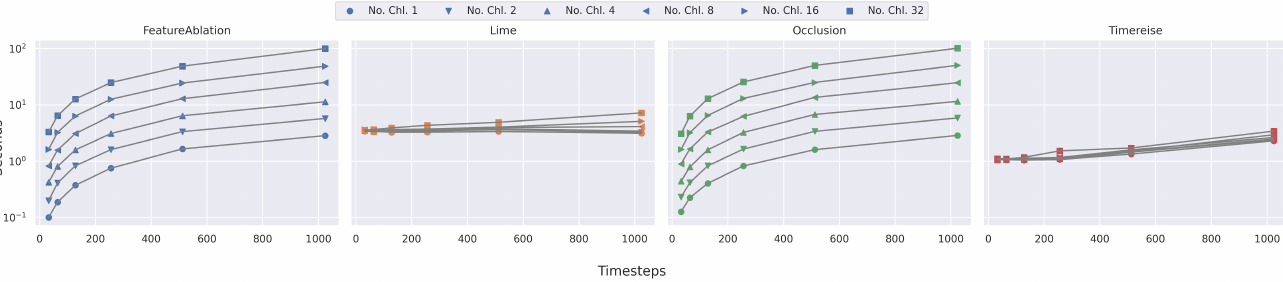
Figure 6. Runtime Parameter dependency. Shows the runtime on synthetic data with different number of timesteps and channels. IntegratedGradients and GuideBackprop are excluded. The runtime of FeatureAblation and Occlusion increase dramatically with the longer sequences. TimeREISE and Lime show a stable